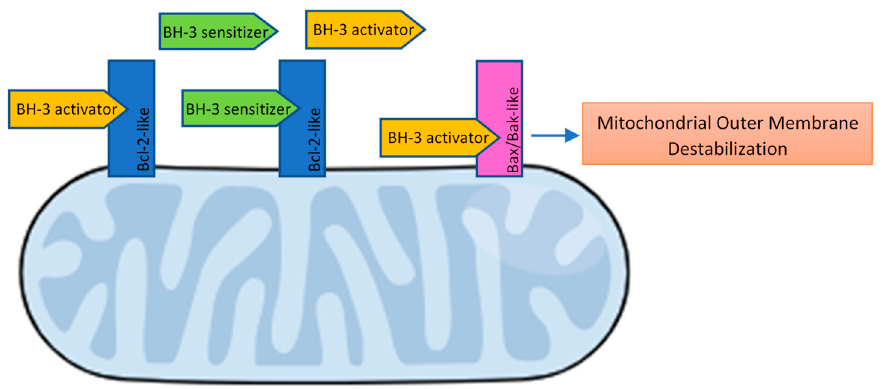
Figure 2. BH3-only effectors and sensitizers mechanism of action. Antiapoptotic Bcl-2-like proteins can sequester and inactivate BH3-activator and sensitizer proteins, preventing apoptosis. Excess BH3-sensitizer proteins prevent the sequestration of BH3-activators by Bcl-2-like proteins, allowing them to directly interact with and activate Bax/Bak-like apoptosis effectors.